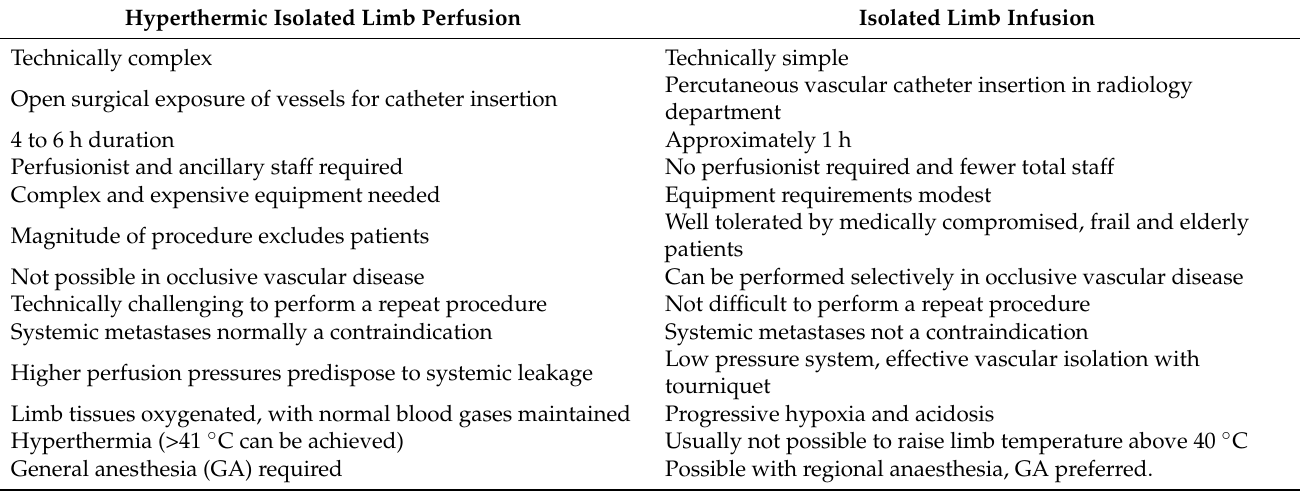
Table 2. Differences between hyperthermic isolated limb perfusion and isolated limb